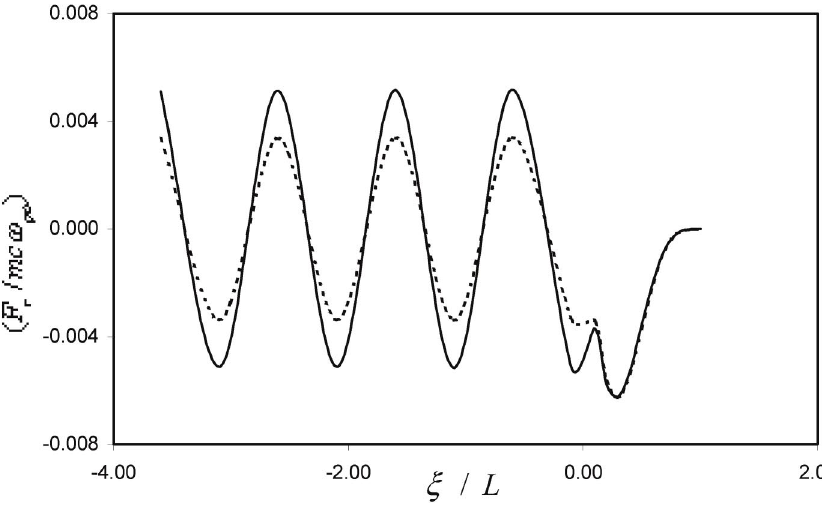
(cid:4) generated by a matched laser pulse, as a function of (cid:29)=L in plasma channel (solid =mc! r po (cid:2) 0 : 1 , $ (cid:2) 15 : 0 & m , r (cid:2) 15 : 0 & m , and r (cid:2) 4 : 0 & m . p o o